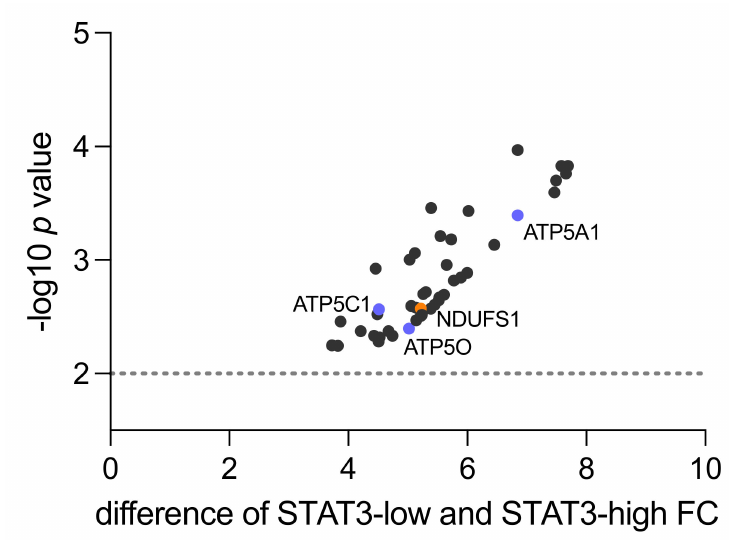
Figure 1. Mitochondrial proteins upregulated in STAT3-low versus STAT3-high samples in proteomic shotgun analysis ( n = 4). The y-axis shows the p value as − log10 and the x-axis indicates the difference in fold change (FC) between low vs. high STAT3 samples. Highlighted are NDUFS1 from complex I (orange) and ATP5O, ATP5A1 and ATP5C1 from complex V (blue). The dotted line represents level of 0.01